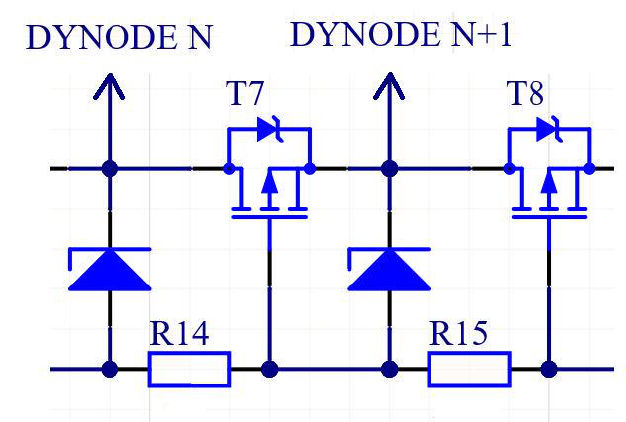
Fig. 4 Connection of a linearized active divider for high pulse